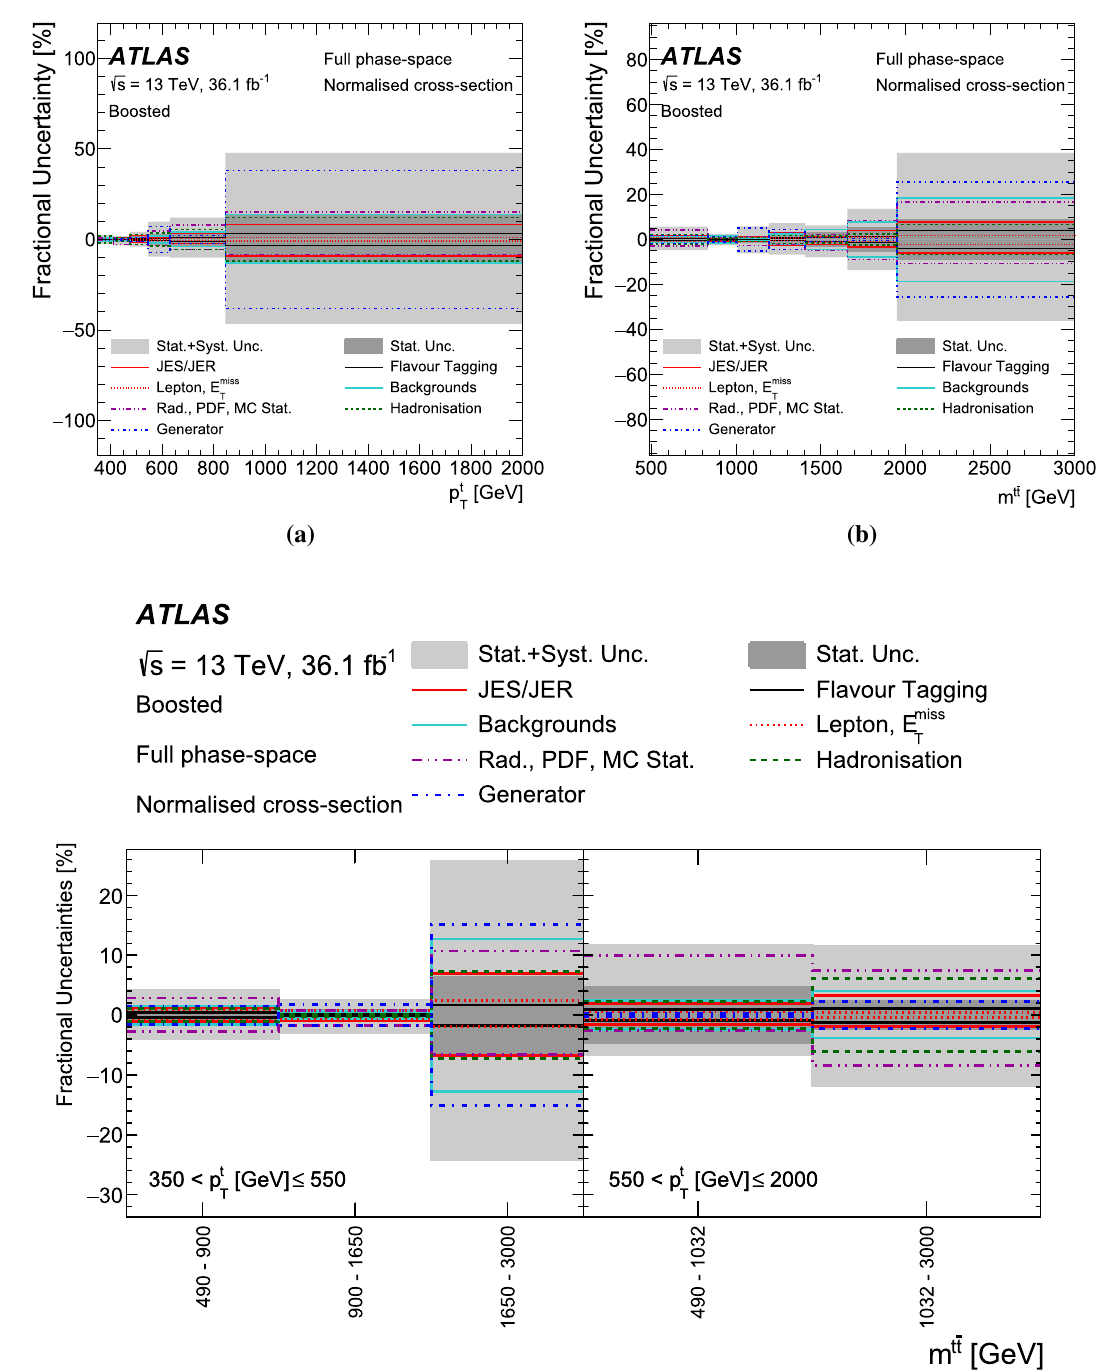
Fig. 21 Uncertaintiesintheparton-levelnormaliseddifferentialcross- sections as a function of a the transverse momentum of the top quark, b the mass of the t ¯ t system and c the mass of the t ¯ t system as a function